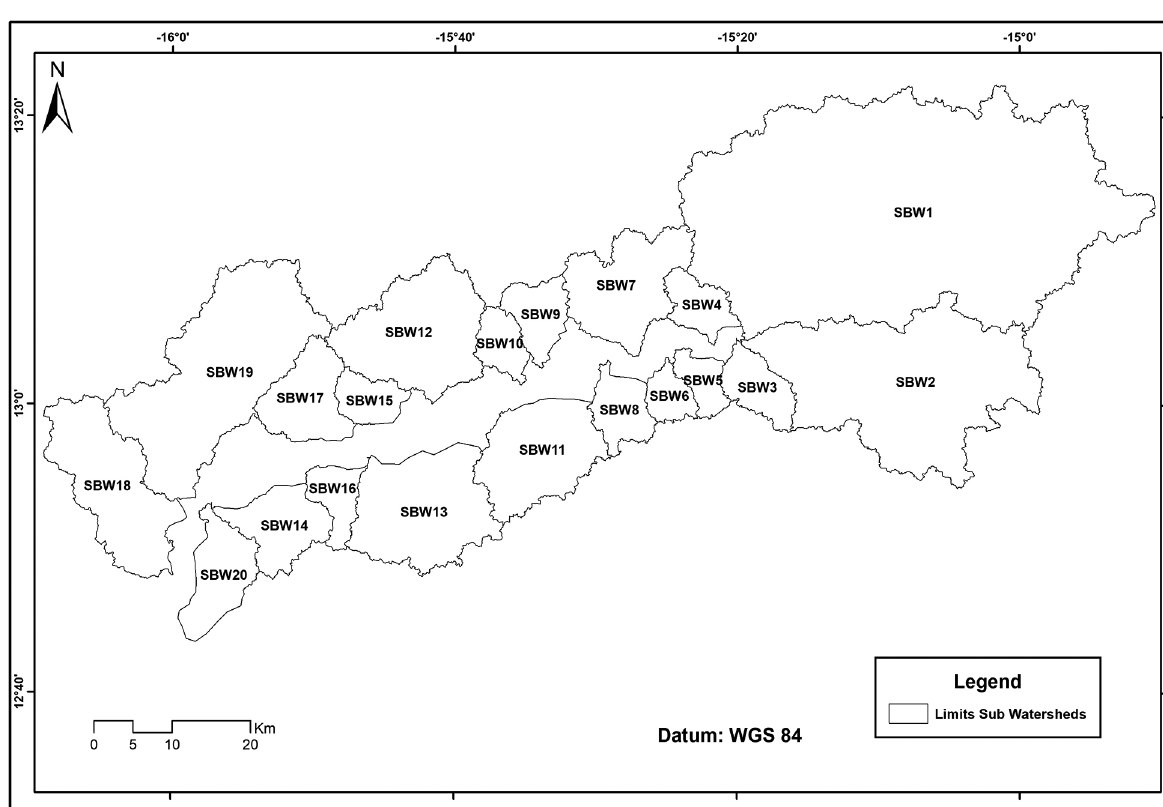
Fig. 2. Sub-basin division of the Soungrougrou